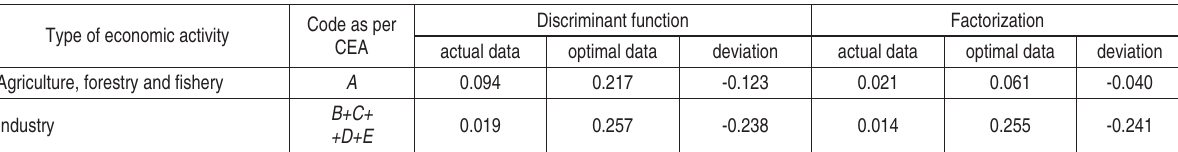
Table 6. Optimal structured credit portfolio developed on the basis of assessing the creditworthiness